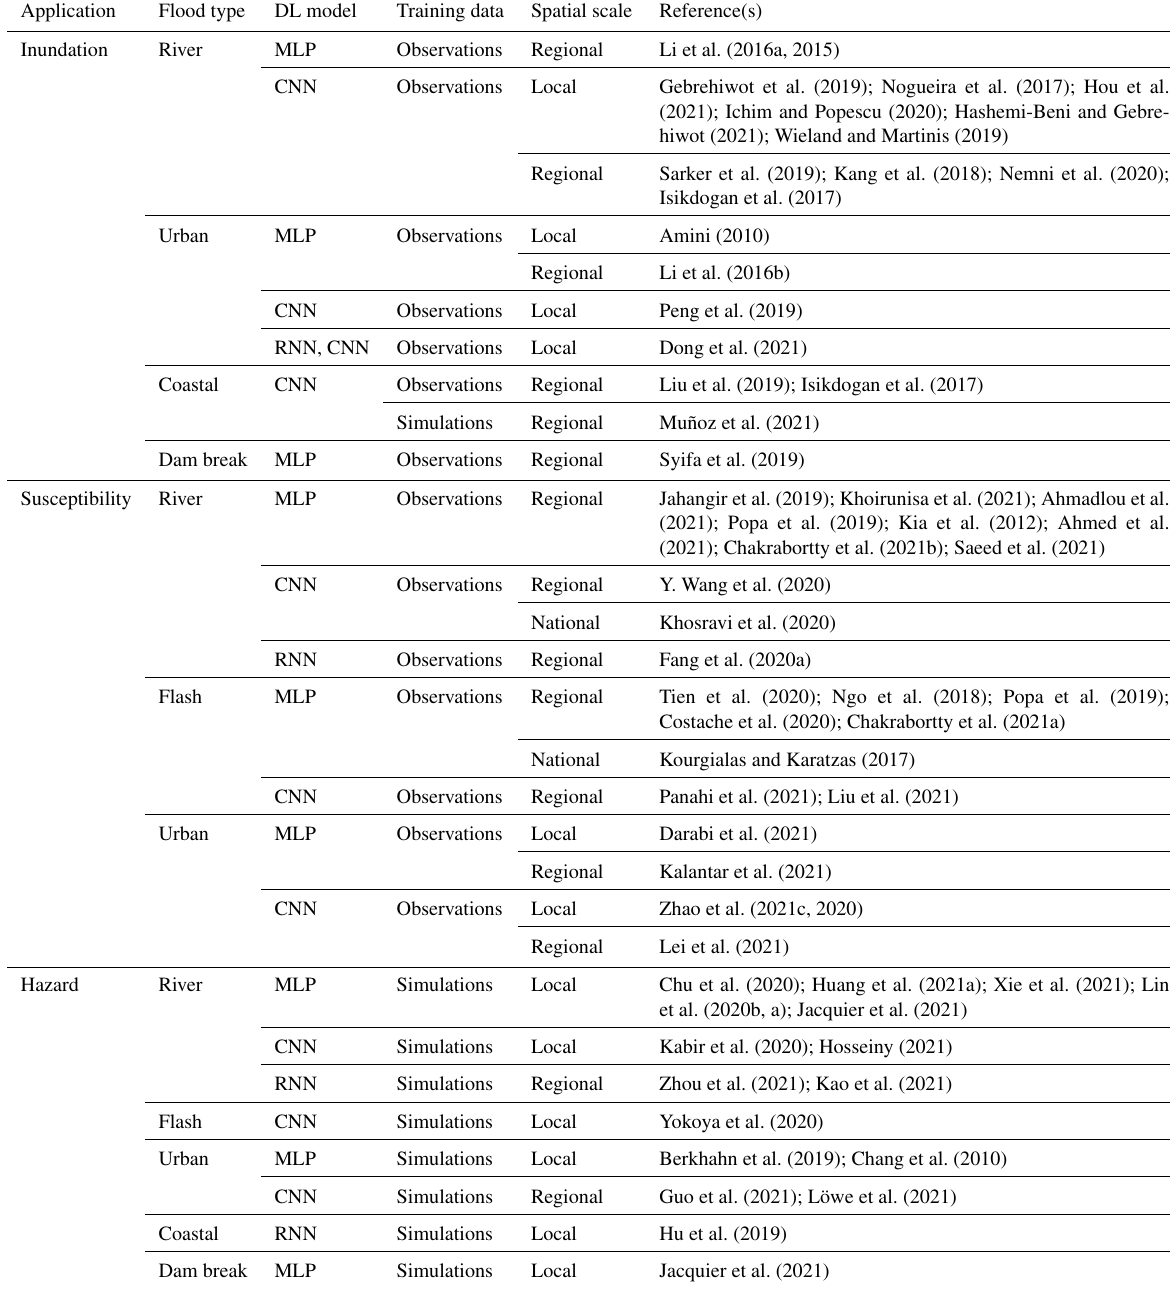
Table 2. Deep learning applications for flood mapping. References are classified in terms of flood mapping application, type of flood, deep learning (DL) model, training data, and spatial